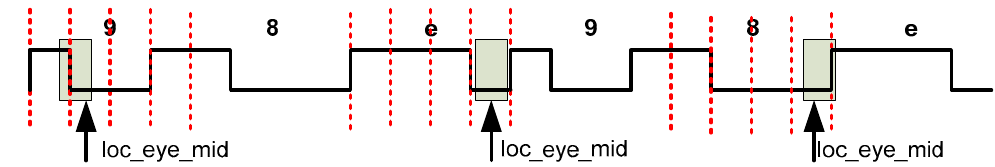
Figure 10. Edge search with the IDELAYE2 component.